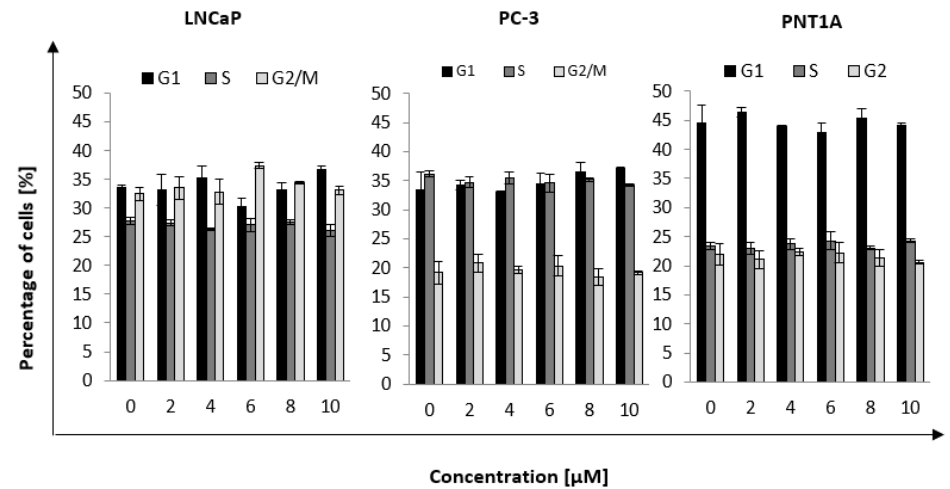
Figure 4. Percentage of cells in the G1, S, and G2 phases of cell cycle, depending on the used nanorods concentration. The values presented in the graph are the mean of the obtained results and, the deviation is the standard deviation. The experiment was performed in triplicate.